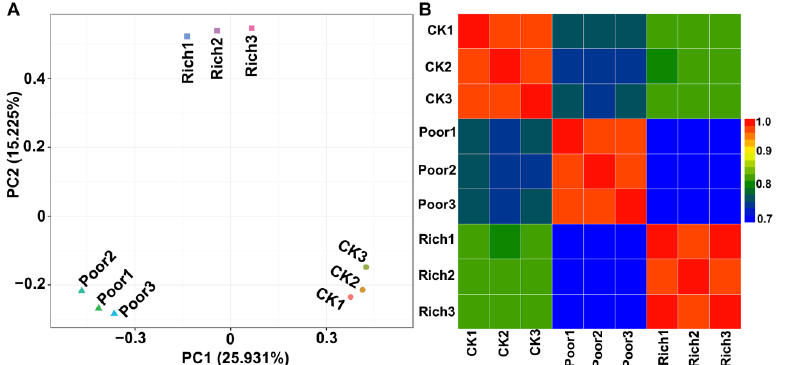
Figure 1. Statistical analysis of sample repeatability and differentially expressed genes. ( A ): PCA analysis; ( B ): correlation analysis.